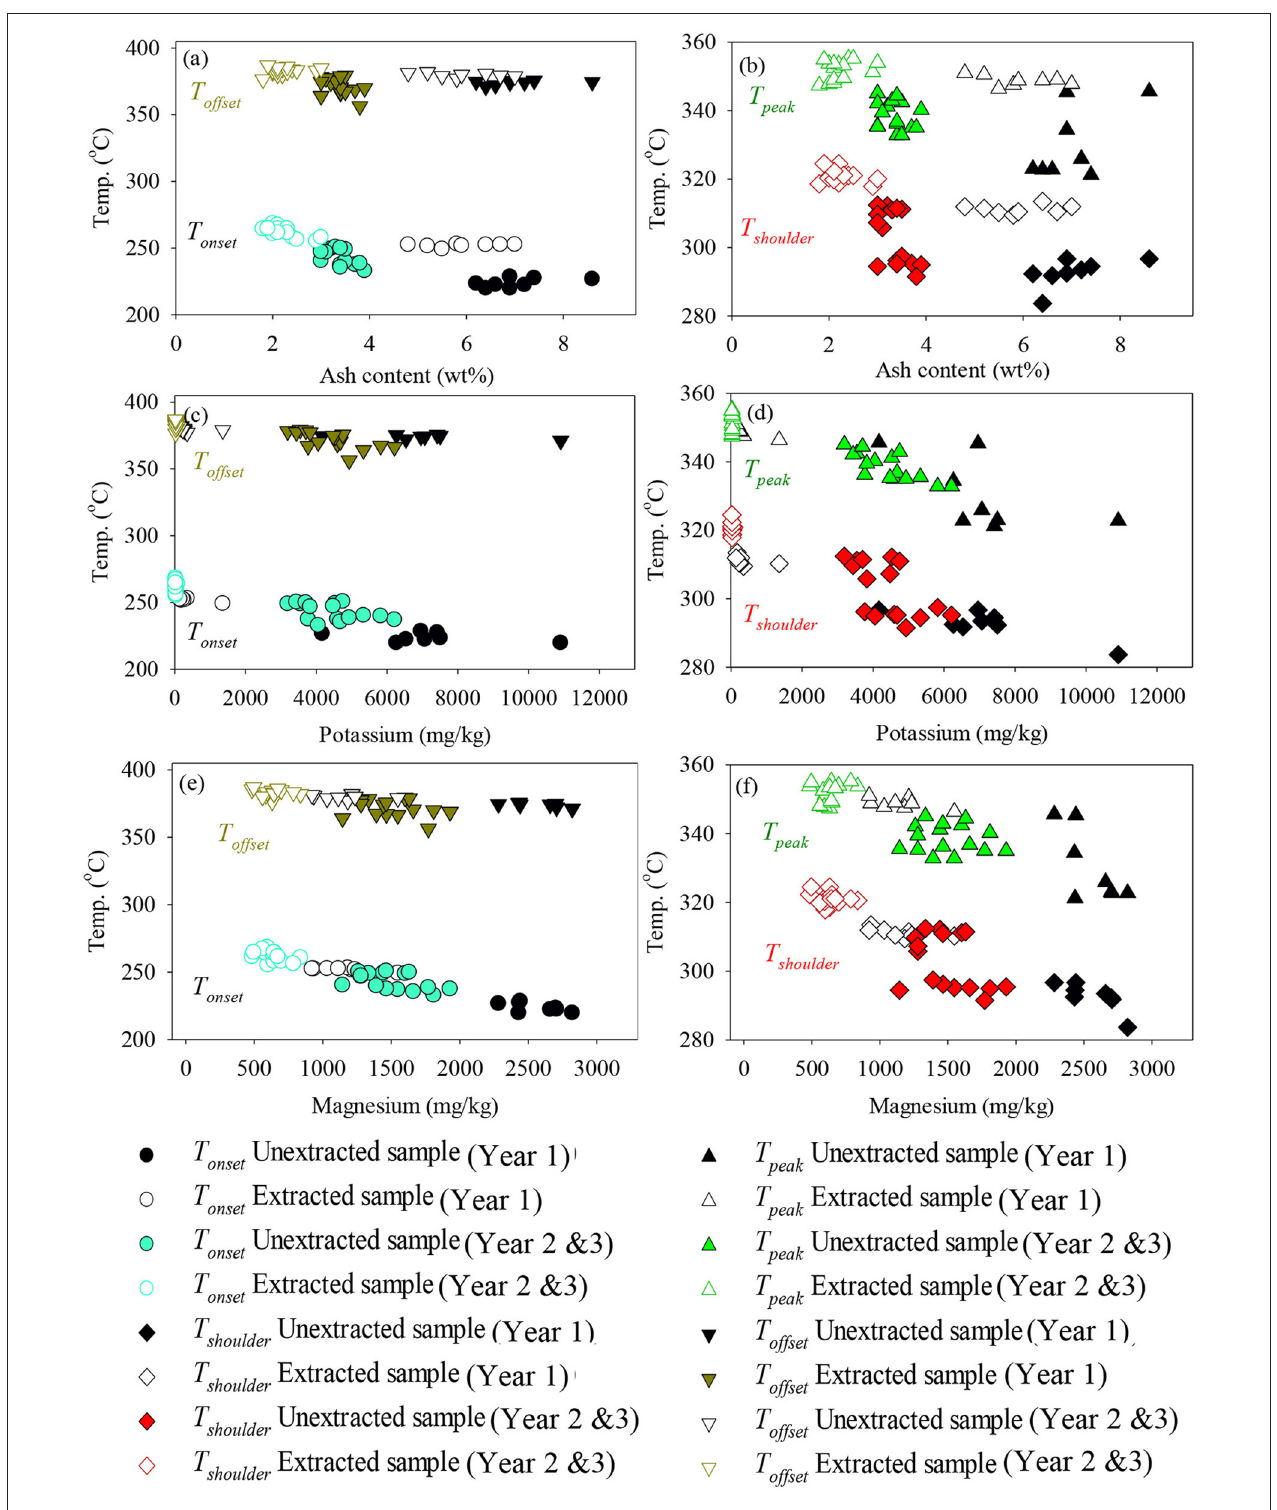
FIGURE 4 | Degradation temperature at which switchgrass decomposition is maximum in the DTG curve associated with ash content, potassium, and magnesium. (A) T offset and T onset with ash content, (B) T peak and T shoulder with ash content, (C) T offset and T onset with potassium, (D) T peak and T shoulder with potassium, (E) T offset and T onset with magnesium, and (F) T peak and T shoulder with